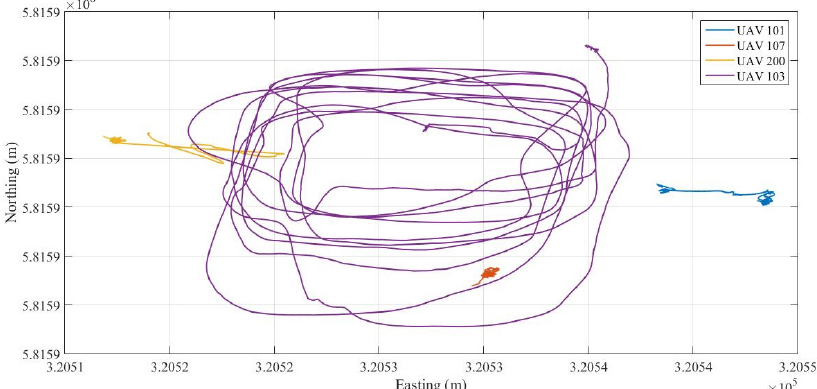
Figure 8. Plan view of the trajectory of the four UAVs in the network.